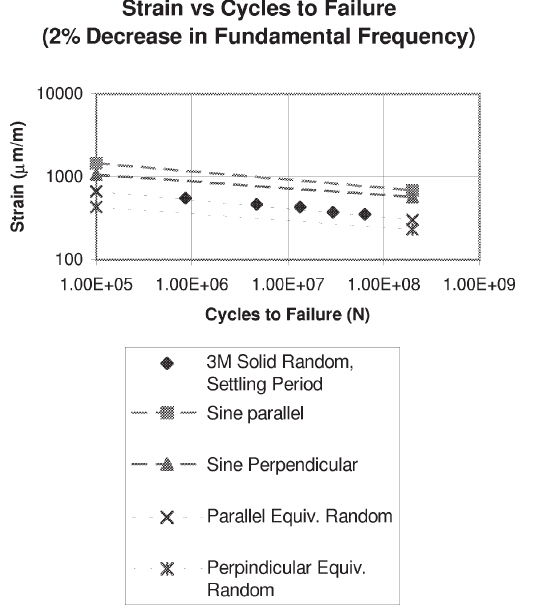
Fig. 4. Comparison with published data.